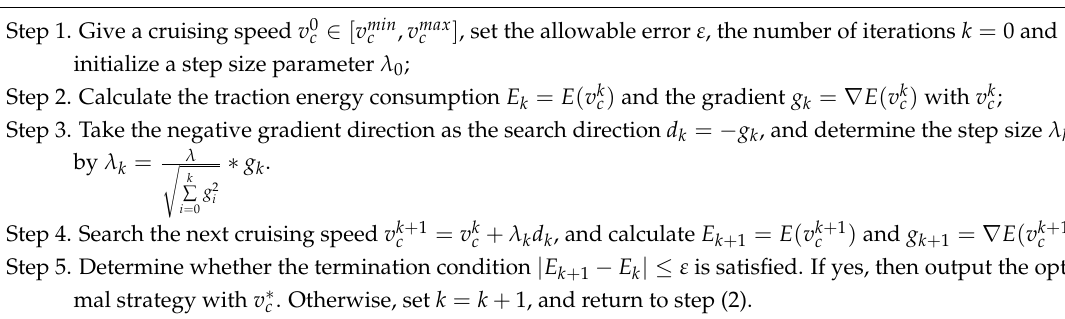
Algorithm 2: The ADG algorithm for calculating the optimal cruising speed.